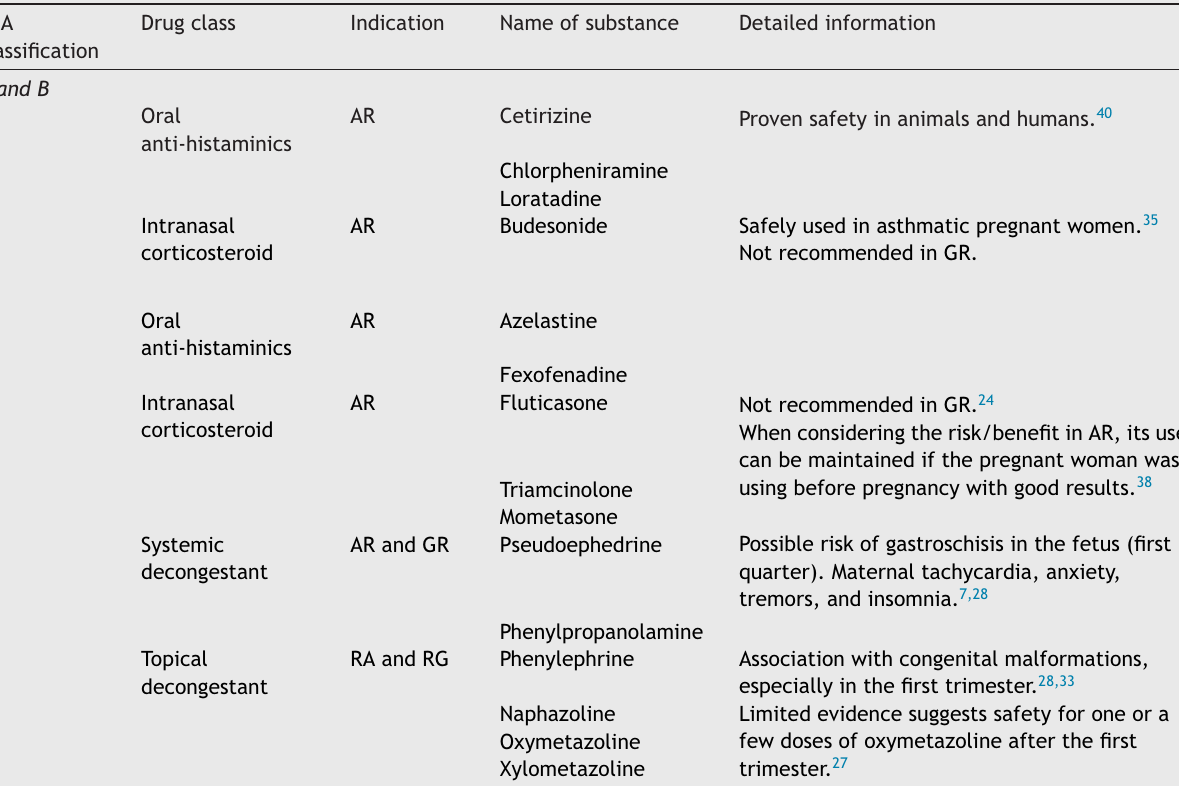
Table 4 Safety level of the most commonly used drugs for the treatment of pregnant women with rhinitis. FDA Detailed information